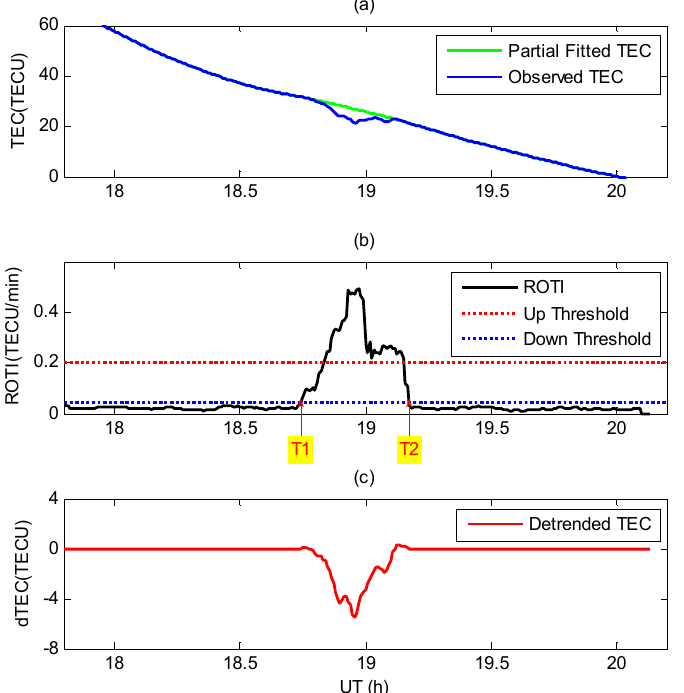
Figure 3. Example of the EPBs detection method in this study using station HKKT and satellite R04 on 28 February 2014. ( a ) Observed total electron content (TEC, blue line) and partially fitted TEC using third-order polynomial (green line); ( b ) the rate of TEC variation index (ROTI, black line) and the up threshold (red dot line) and down threshold (blue dot line) for irregularity; ( c ) detrended TEC (red line). The annotations “T1” and “T2” indicate the initial and end time of EPB.